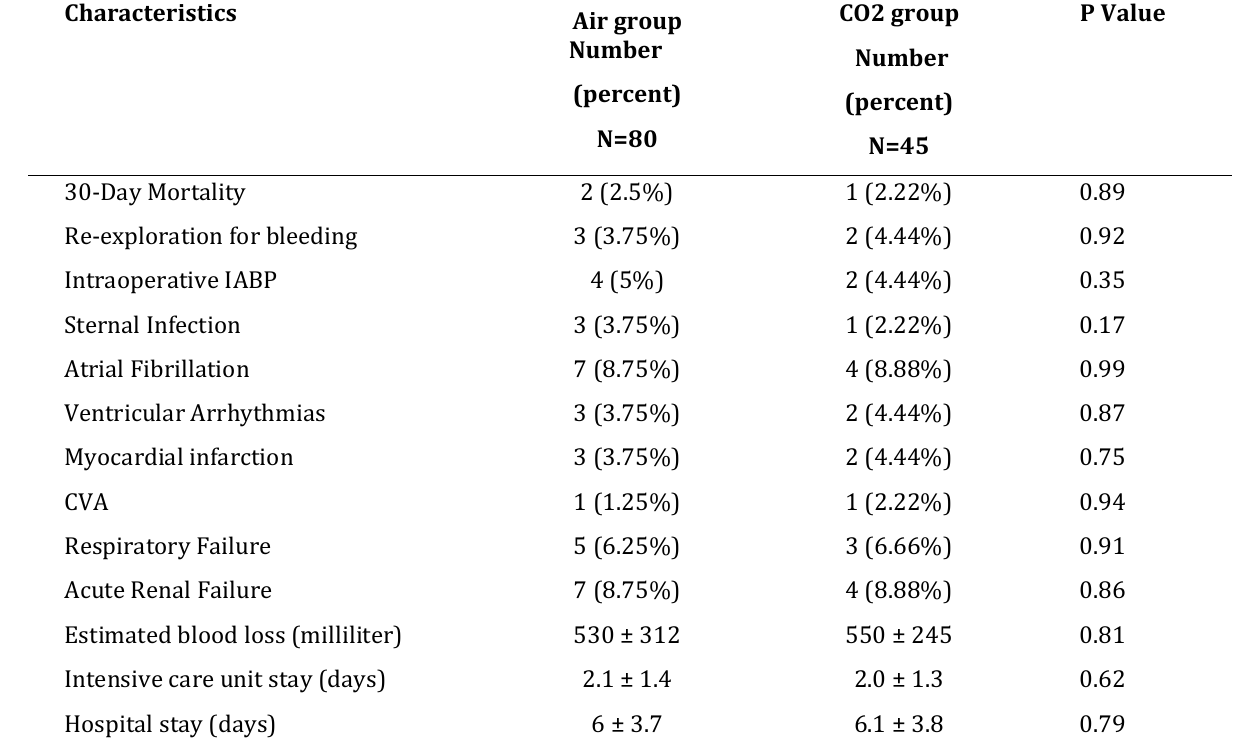
Table 2: Postoperative Morbidity and Mortality No (%)